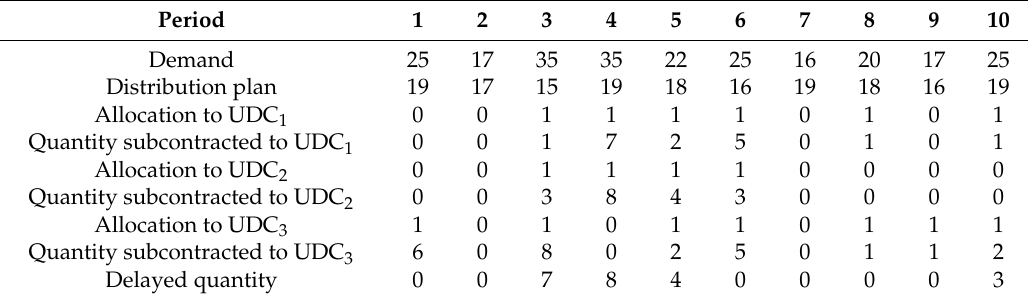
Table 8. Final distribution plan using the subcontracting strategy with available capacities.